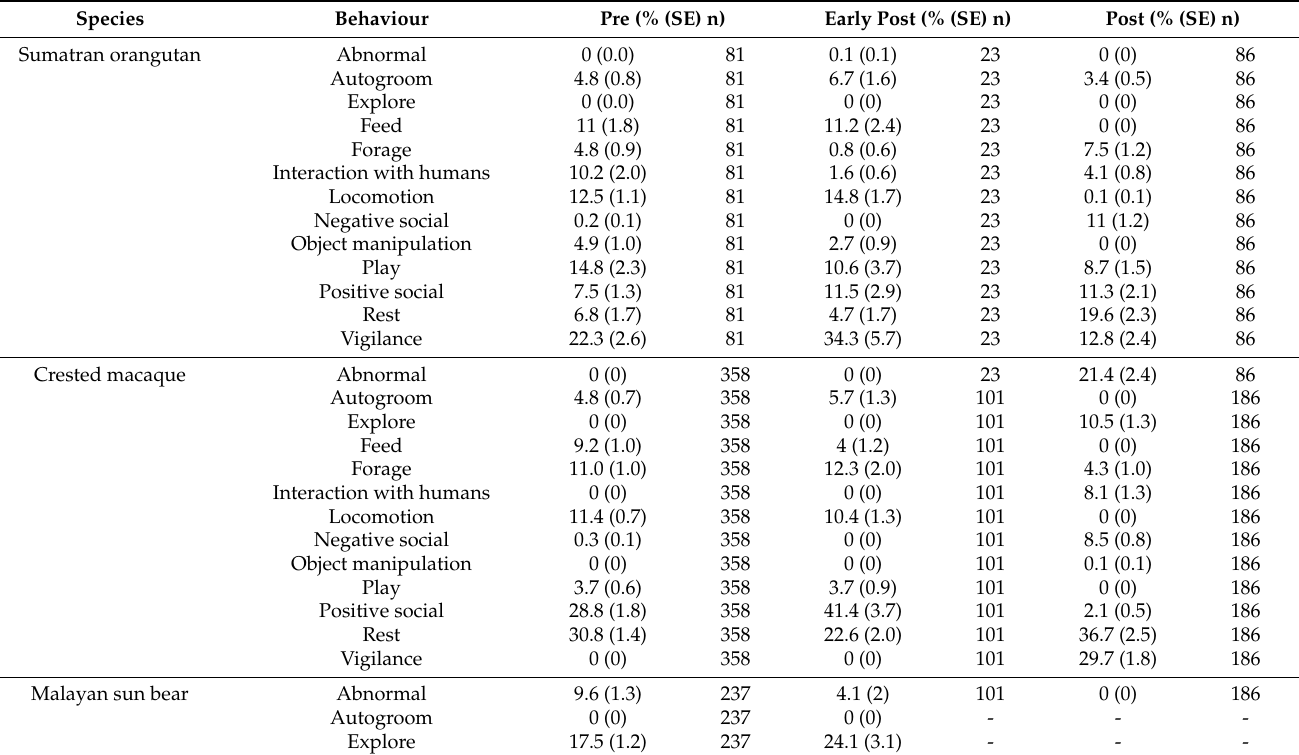
Table A9. Raw mean proportions (with standard errors) of time spent in combined behavioural categories (expressed as a percentage of the total activity budget) under the pre-, early-post- and post-enclosure-move conditions for each species studied. ‘n’ refers to the number of sampling points for each data collection